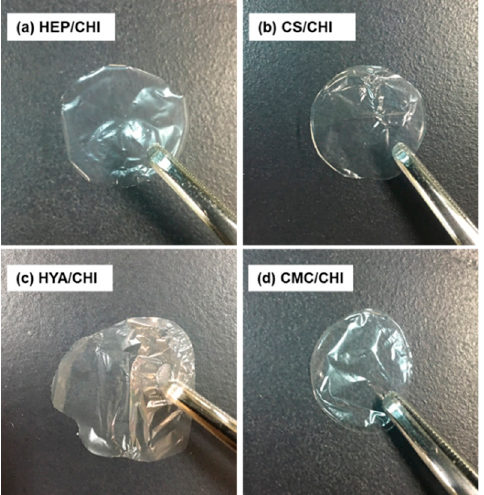
Figure 2. Macroscopic images of the polysaccharide composite films made of HEP/CHI ( a ), CS/CHI ( b ), HYA/CHI ( c ), and CMC/CHI ( d ).